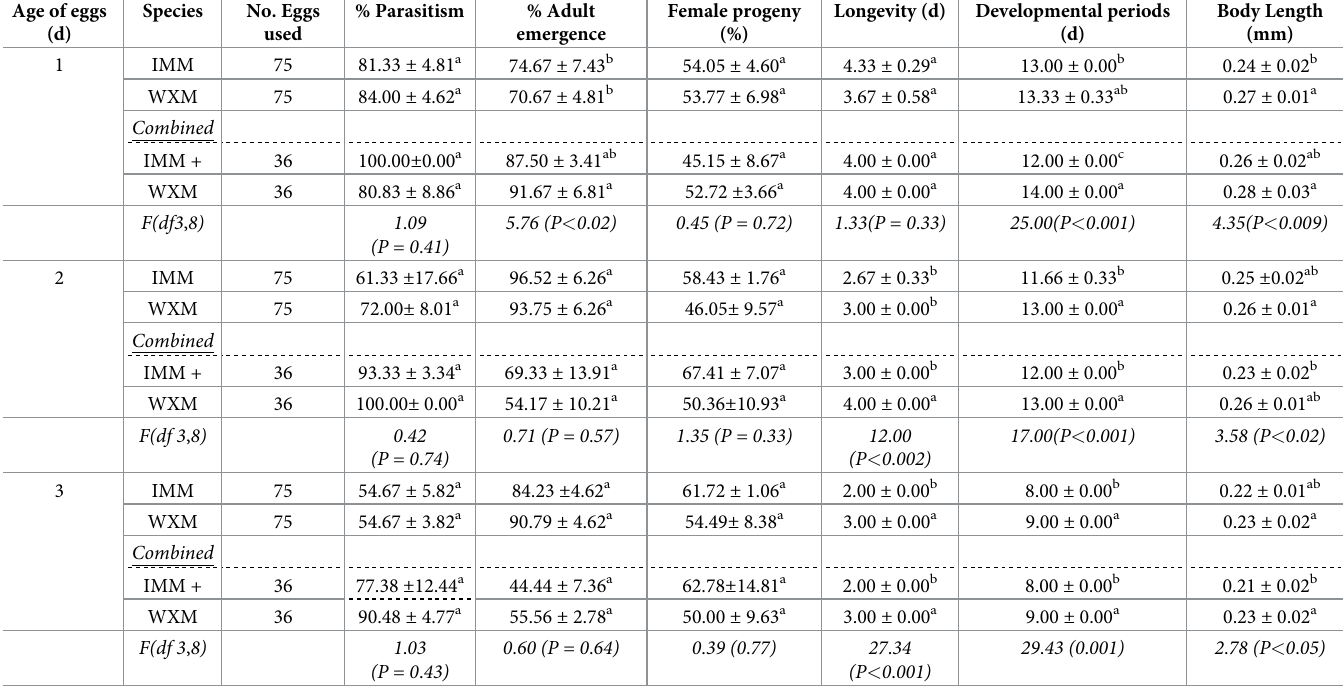
Table 1. Age-dependent (mean ± SE) biological traits in T . evanescens reared on eggs of P . interpunctella (IMM) and G . mellonella (WXM), placed either alone or simultaneously.